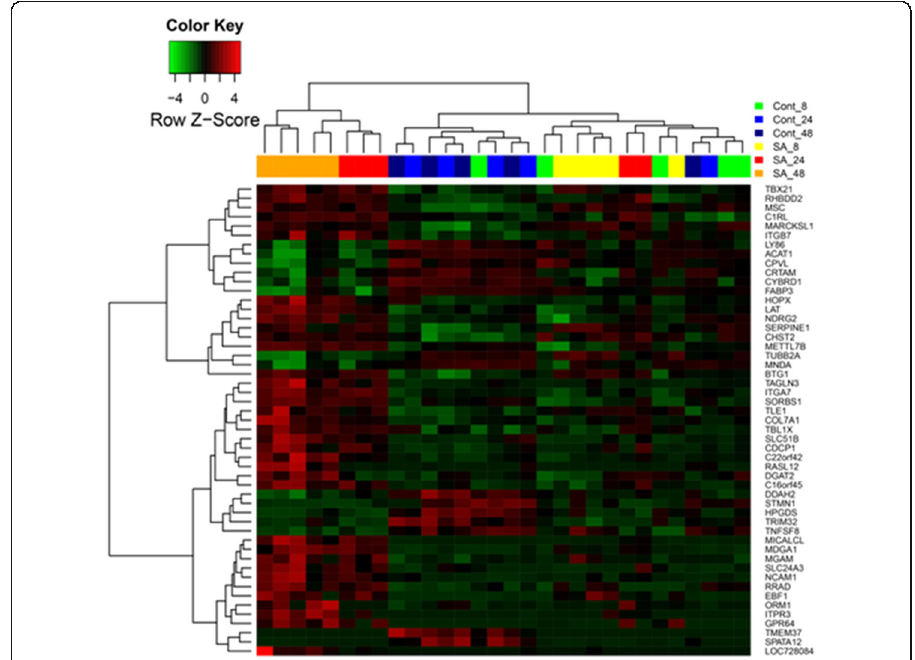
Fig. 5 Heat map of hierarchical clustering of common DEGs in Comparison 3. “ Red ” : high expression, “ green ” : low expression